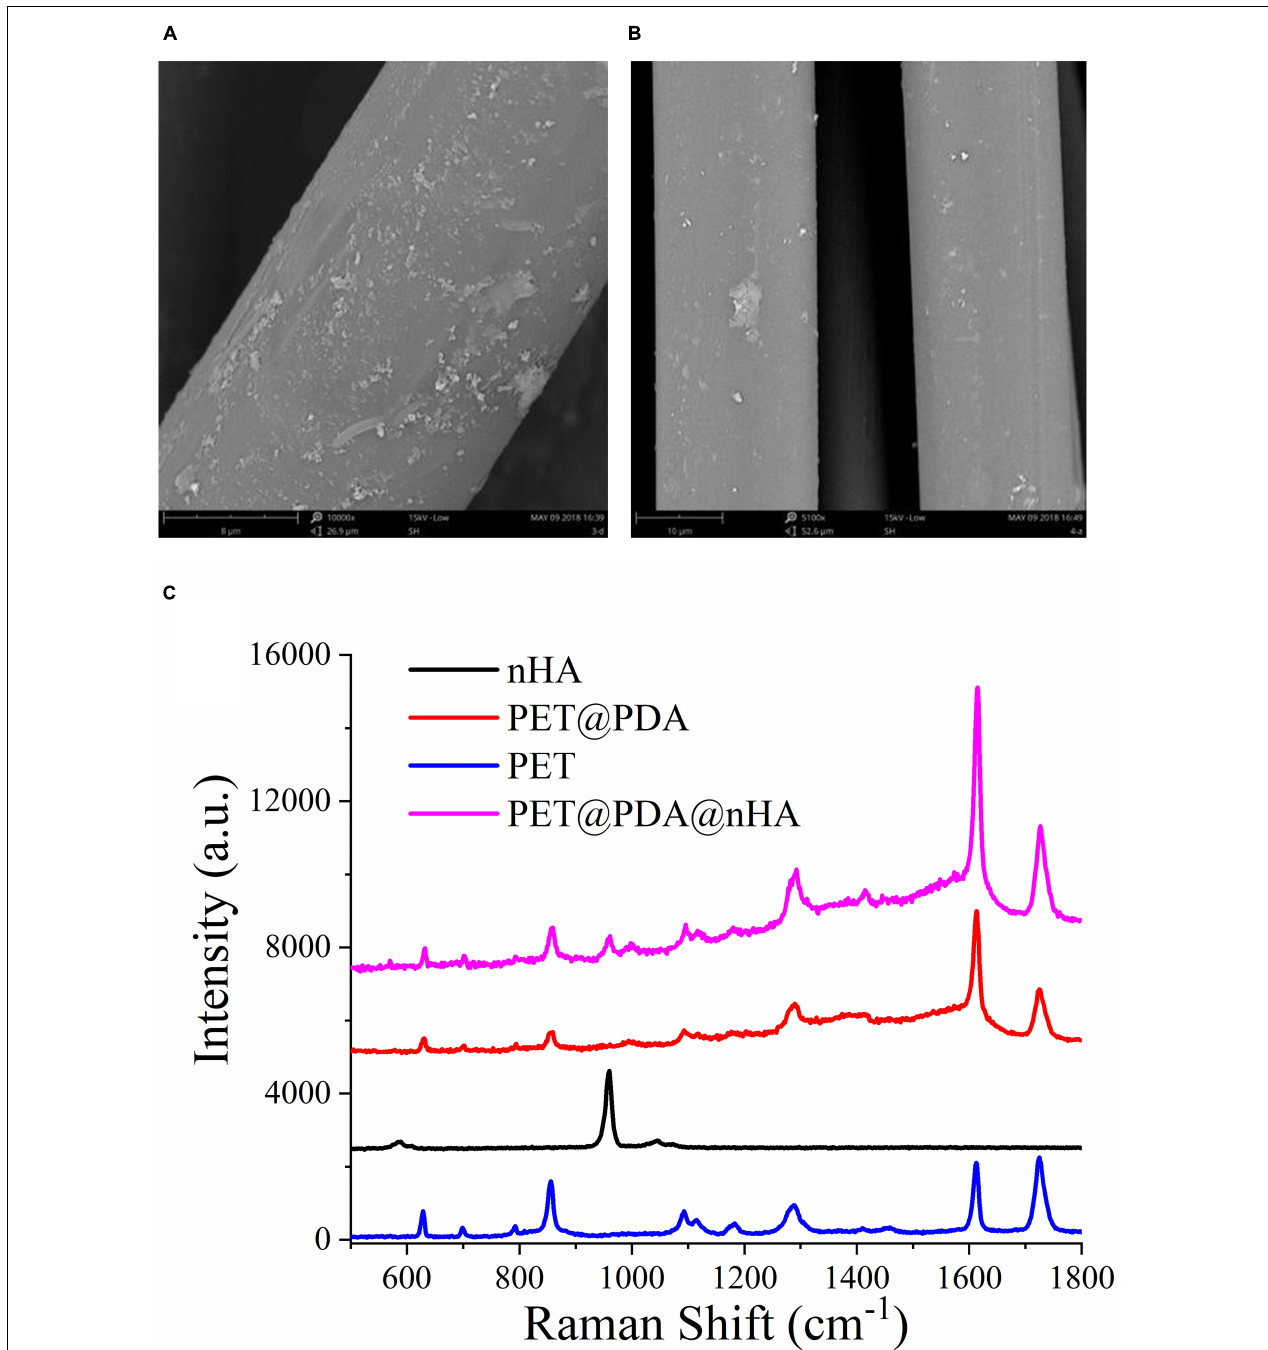
FIGURE 5 | SEM images of PET@PDA@nHA, which were modified by two steps (A) and one step (B) reaction, and Raman spectra of PET and PET@PDA@nHA (C)